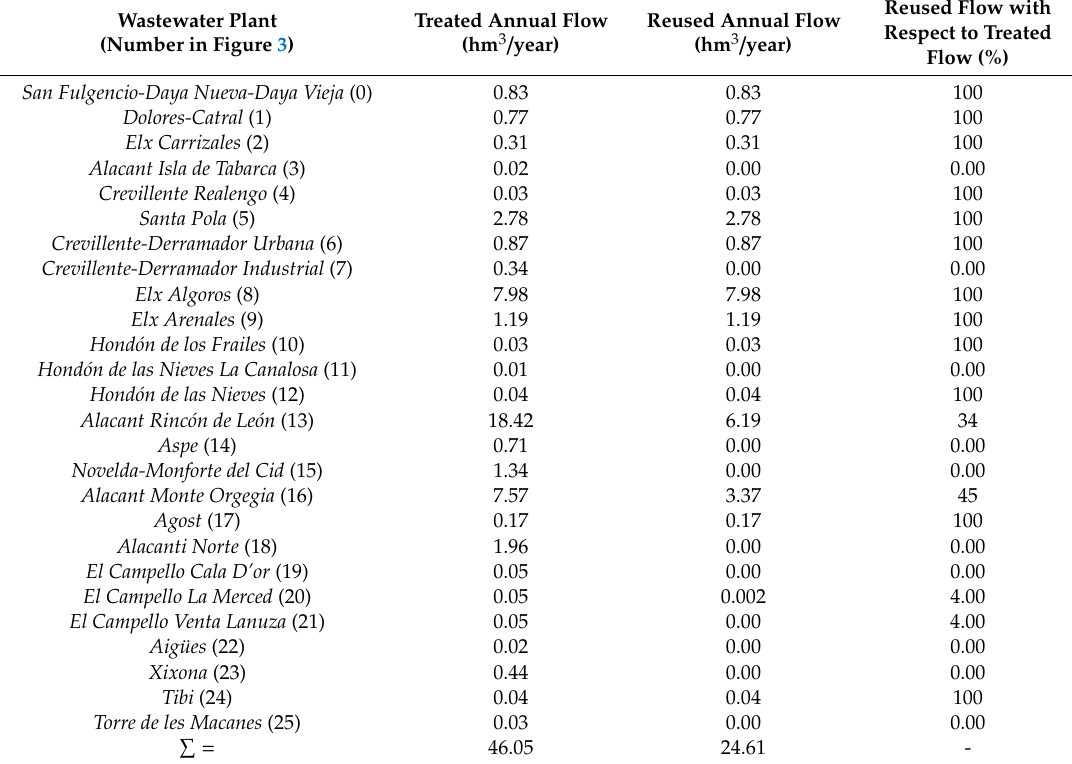
Table 2. Wastewater plants located in the study area and treated volumes (hm 3 / year). Source: elaborated with data from [20] and private information.